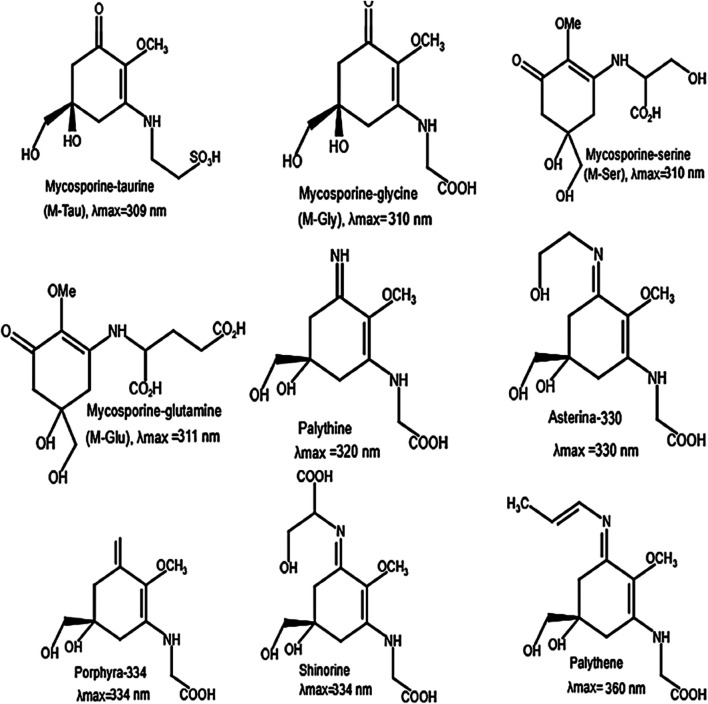
Chemical structure of some MAAs and their maximum absorption (λmax) (adapted from Chrapusta et al., 2017).